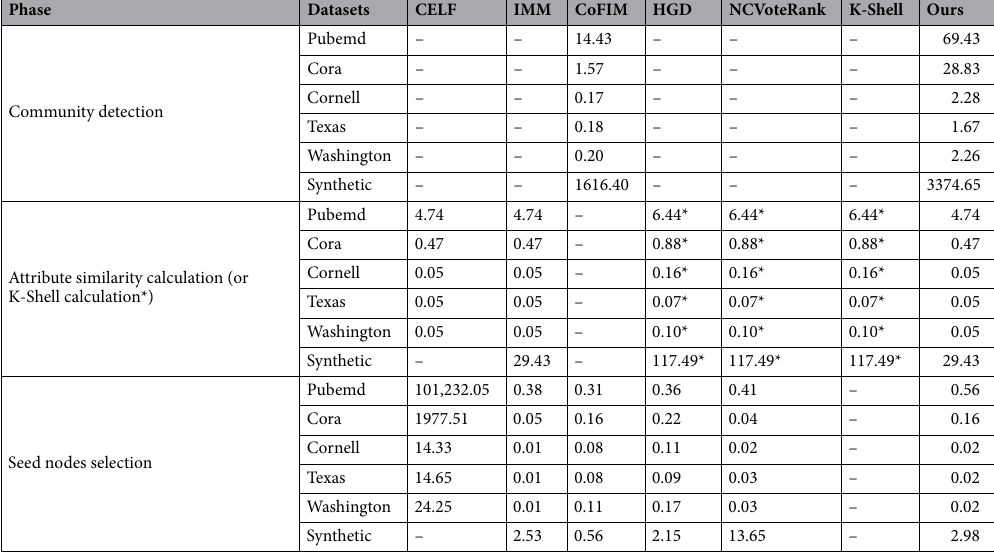
Table 5. Running time (in seconds) for different algorithms on six datasets. The number of seed nodes m is 25. Symbol ‘–’ indicates that the corresponding cell has no